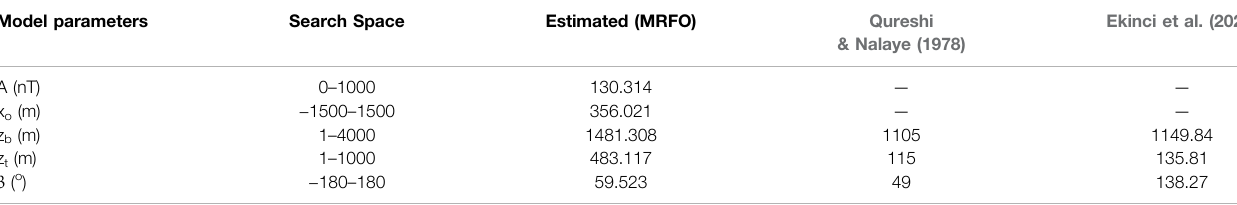
TABLE 7 | Recovered parameter results and comparative analysis for Lanchlan Anomaly,